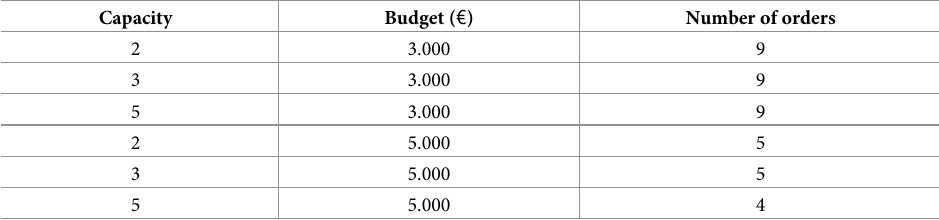
Table 10. Optimization results for varying capacity and budget parameters.